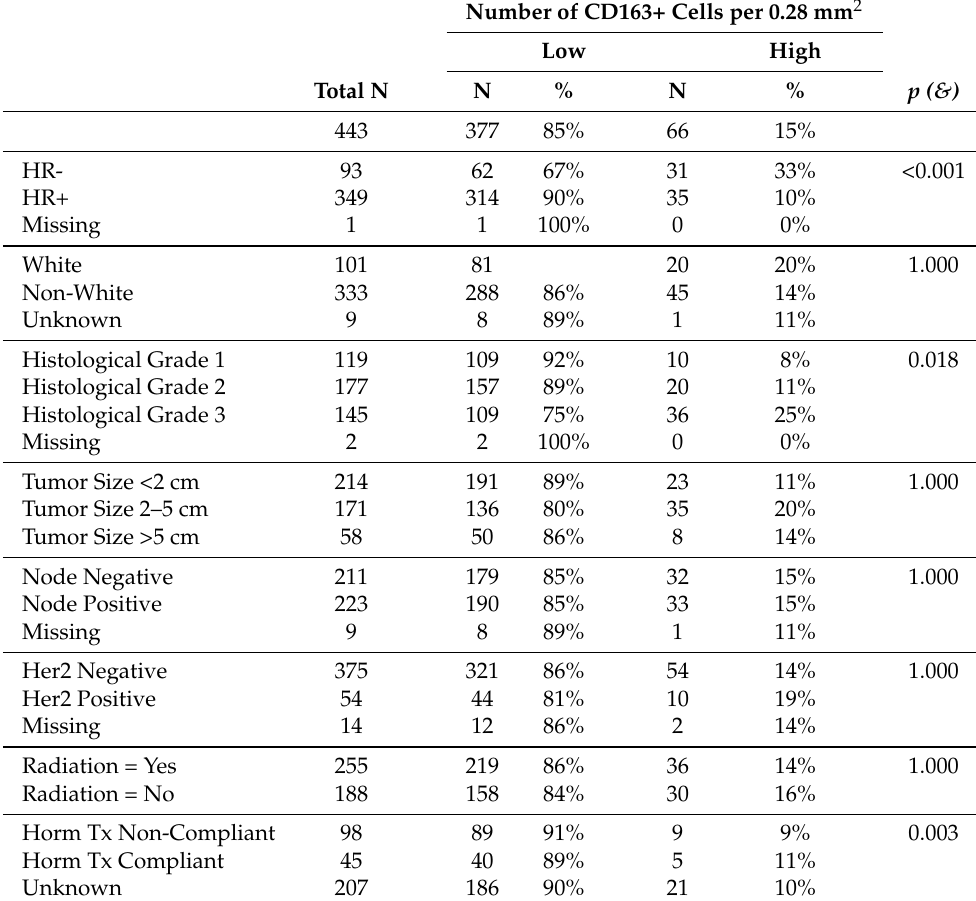
Table 1. Associations between dichotomized count of CD163+ cells and other prognostic